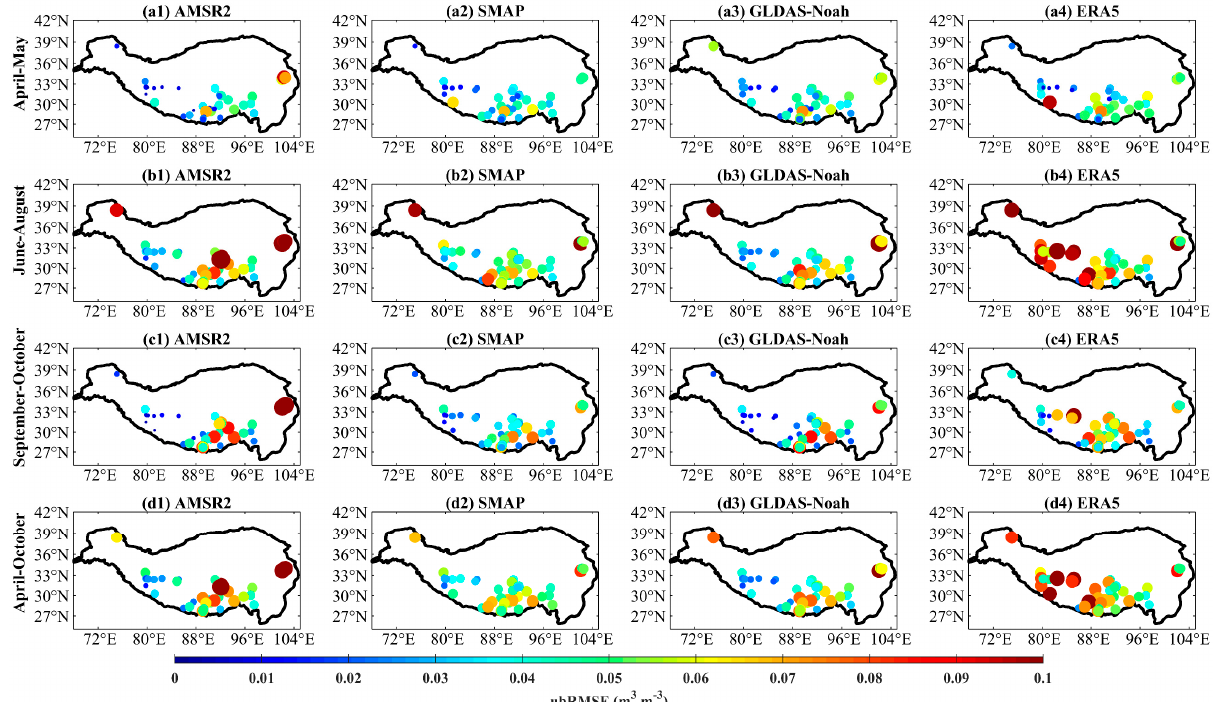
Figure 8. Spatial distributions of ubRMSE for daily AMSR2, SMAP, GLDAS-Noah, and ERA5 SM in different seasons during the non-frozen period from 2015 to 2016 in the TP. The size of the circles represents the absolute value of ubRMSE at each observation site.